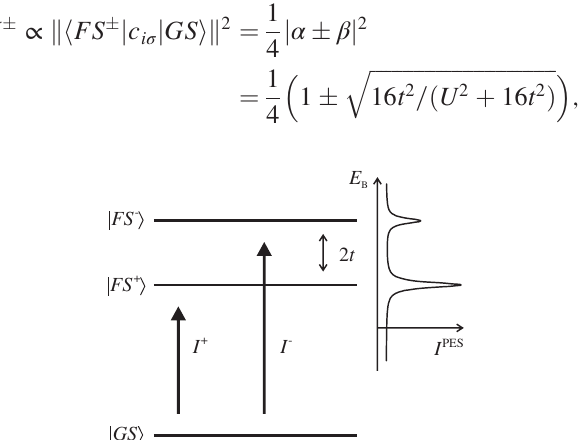
FIG. 6. Total-energy-level diagram for the photoemission process in a hydrogen molecule model. The two accessible final states j FS þ i and j FS − i yield two lines in the spectrum of intensities I þ and I − , respectively, according to the initial-state coefficients α and β . The corresponding spectrum is indicated on the right.